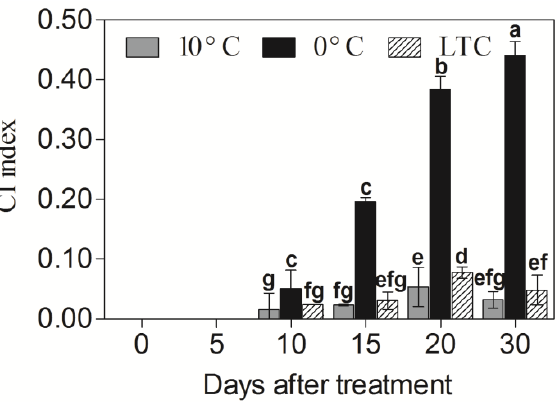
Figure 5. Estimation of CI in ‘Huangguan’ pear fruit at different temperature storage. Data are means of three replicates, and error bars indicate SD. Different letters (a–g) above the bar chart indicated significant differences ( p < 0.05) by Duncan’s multiple comparison test.